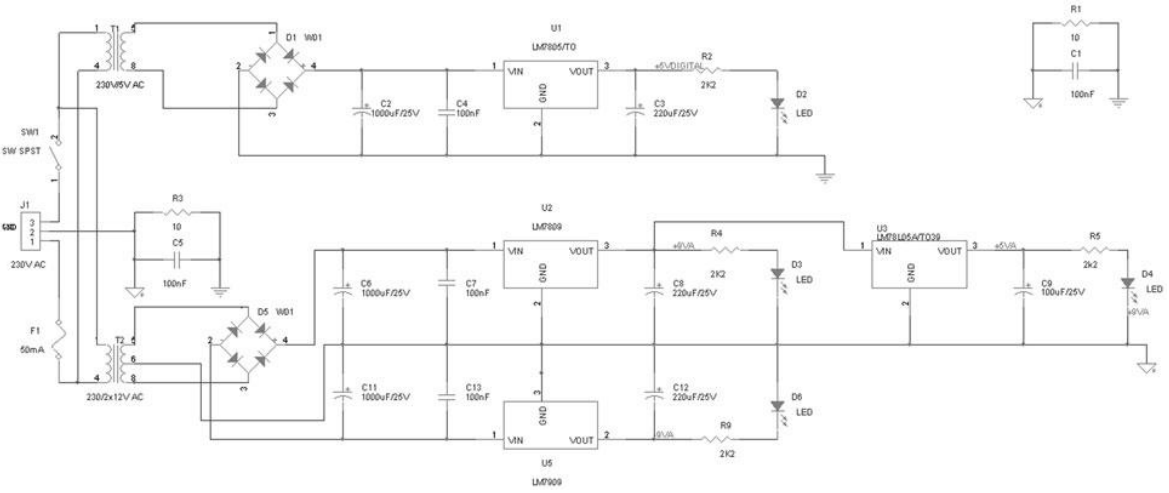
FIGURE 3. Diagram of power supply